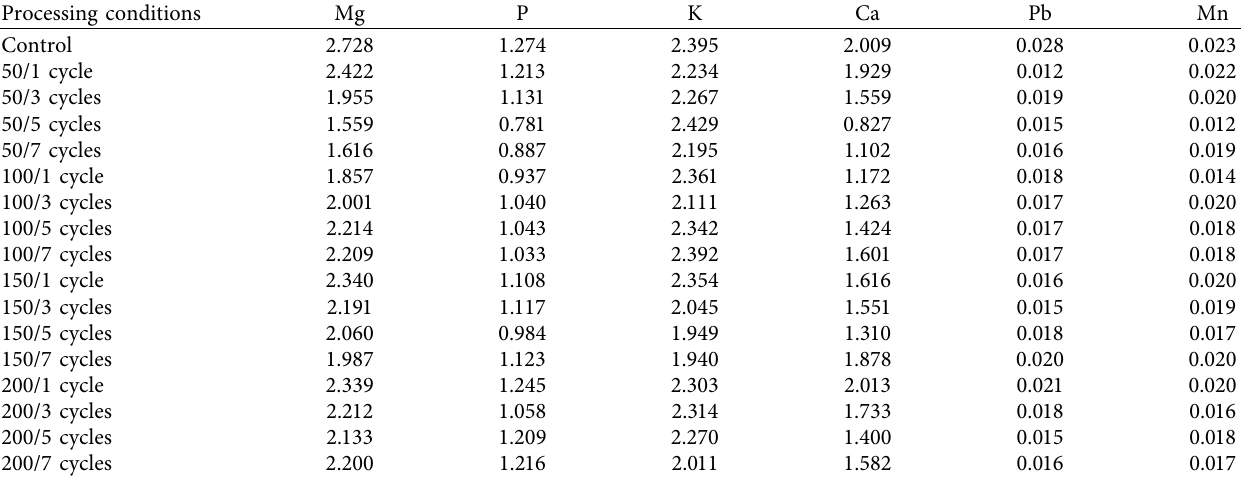
Table 1: Metal and mineral composition (in mg/L) of control and microfluidization sugarcane juice.